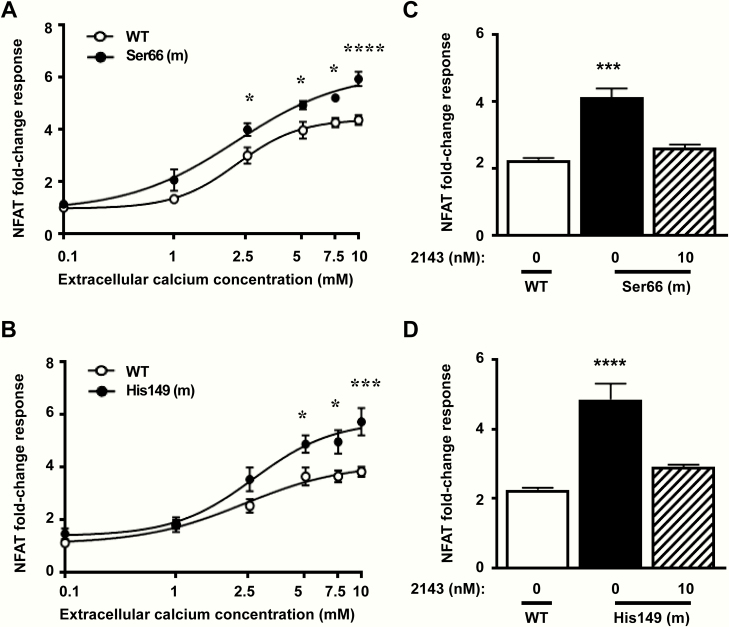
NFAT-response element (NFAT-RE) luciferase reporter responses of the Ser66 and His149 Gα 11 mutants and effects of NPS 2143 (2143) treatment. [Ca2+]e-induced NFAT-RE luciferase reporter responses of HEK-CaSR cells transfected with WT (open symbols) or mutant (m) (filled symbols) (A) Ser66 or (B) His149 Gα 11 proteins. Responses at each [Ca2+]e are expressed as a fold-change of low (0.1 mM) [Ca2+]e responses, and shown as mean ± SEM of 12 independent transfections. NFAT-RE luciferase reporter activity increased in all cells in a concentration-dependent manner but was significantly greater in mutant cells. Statistical analysis comparing mutant to WT responses by 2-way ANOVA with Tukey’s multiple-comparisons test. (C-D) [Ca2+]e-induced NFAT-RE reporter responses to 7.5 mM Ca2+e in HEK-CaSR cells transfected with WT (open bar) or mutant (filled bar) (C) Ser66 or (D) His149 Gα 11 proteins. The addition of 10 nM NPS 2143 rectified the elevated NFAT-RE reporter responses of the mutant (hatched bars) to WT (open bars) levels. Responses are expressed as a fold-change of low (0.1 mM) [Ca2+]e responses, and shown as mean ± SEM of 4 independent transfections. Statistical analyses were performed by 1-way ANOVA with Dunnett’s multiple comparisons test compared to the WT response. ****P < 0.0001, ***P < 0.001, *P < 0.05 for all panels.